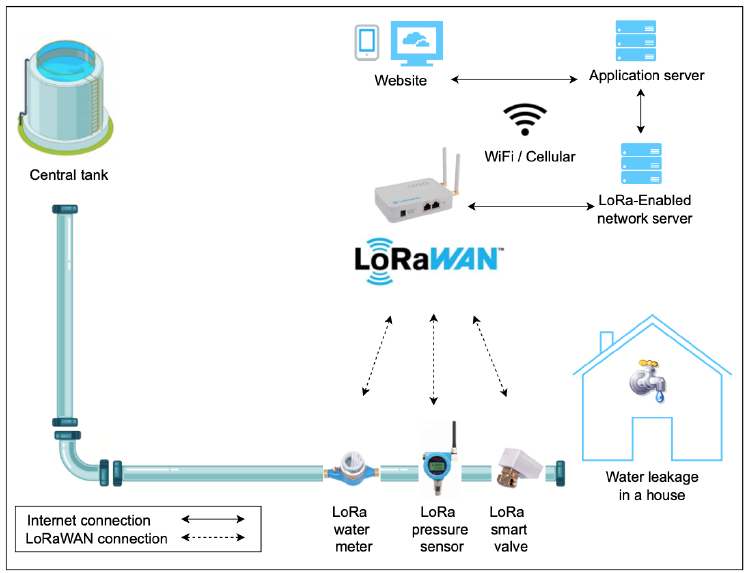
Figure 2. Architecture of LoRaWAN-based water monitoring and leakage detection